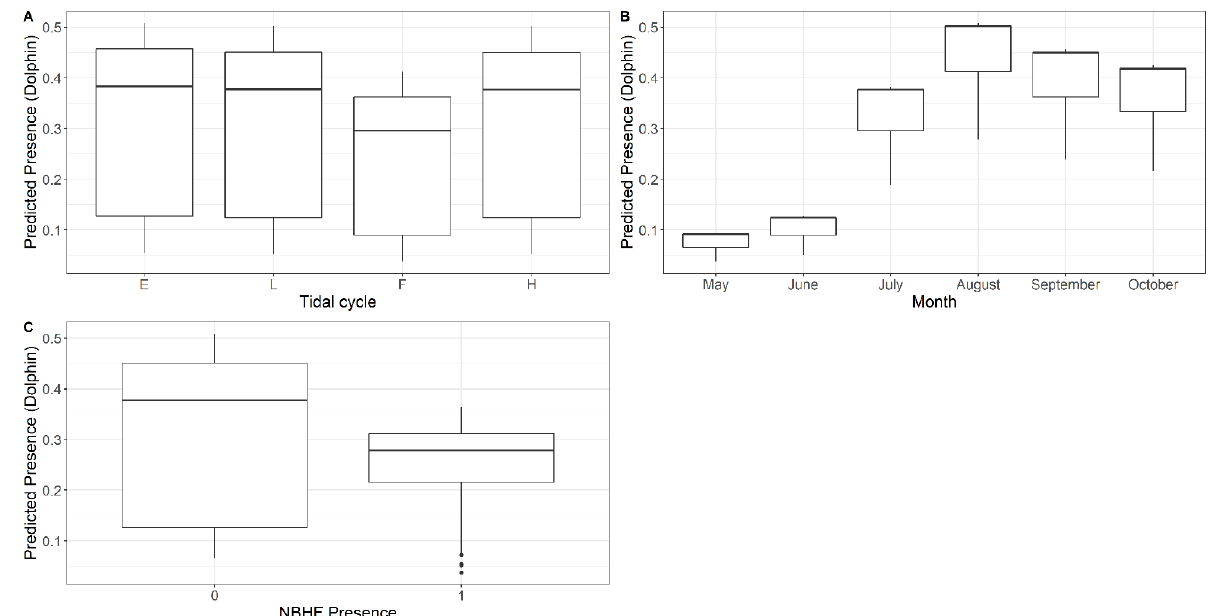
Figure 2. The predicted probability of bottlenose dolphin presence at Brandon Bay according to: ( A ) tidal cycle, where “E” = ebb tide, “L” = low tide, “F” = flood tide, and “H” = high tide; ( B ) month, from May to October; ( C ) harbor porpoise (NBHF) presence, where “0” represents the absence of harbor porpoises, and “1” represents harbor porpoise presence.